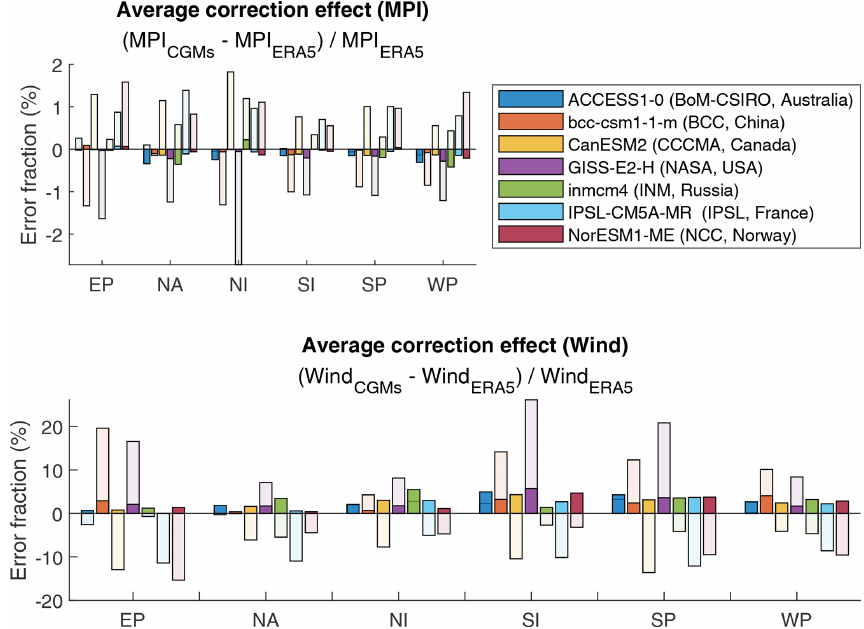
Figure 22. Relative error at the level of maximum potential intensity (MPI) computed with ERA5 and climate data produced by the seven climate models for the historical period. The transparent bars represent original errors, and the color parts represent the residual relative error after CDF-t correction averaged over 30 years of cyclones.